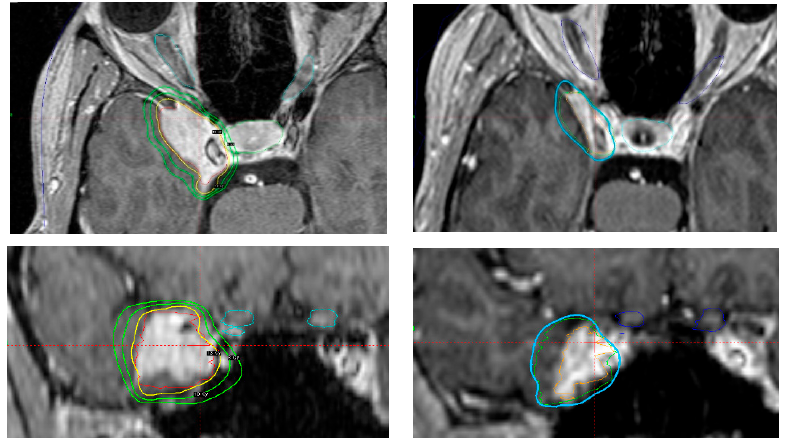
Figure 5. Axial and coronal contrast-enhanced MRI-based treatment ( left top and bottom ) and imaging follow-up 9 years and 6 months after treatment ( right top and bottom ). Imaging-defined CSM treated in a 44 year-old woman reporting right periorbital dysesthesia. No further neurological deficits. No previous surgery. In order to avoid future tumour-associated complications due to the eloquent location, definitive SRS was performed with 13 Gy prescribed to the 65% isodose line. After a follow-up of 114 months, target volume decreased from 5.65 cc to 2.38 cc. The patient developed no new neurological deficits and the periorbital dysesthesia had regressed. Table 3. Progression-free survival rate at 5, 7.5 and 10 years after SRS *.